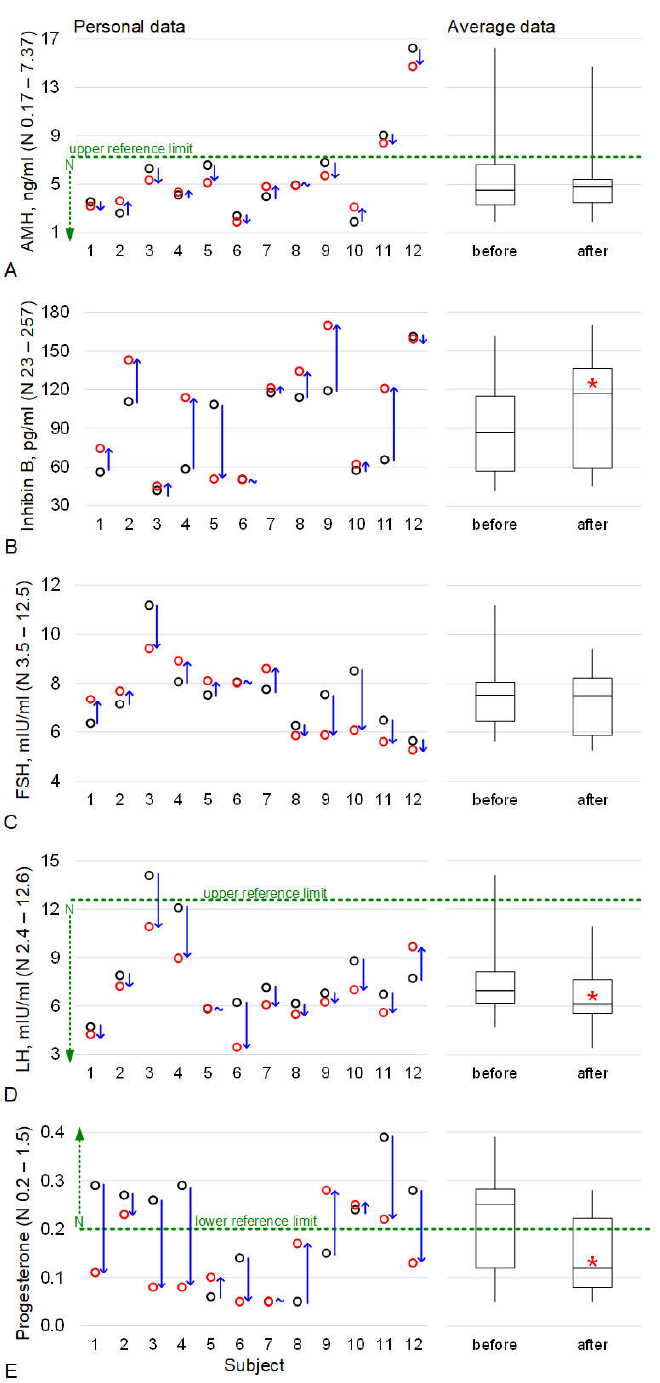
Figure 1. The concentration of hormones before and after a 5-day “dry” immersion. ( A ) anti-Mullerian hormone (AMH), ( B ) inhibin B, ( C ) follicle-stimulating hormone (FSH), ( D ) luteinizing hormone (LH), ( E ) progesterone (PG). The individual data are presented on the left side of each panel (1–12 are the conditional numbers of the subjects). The black circles indicate the values before immersion, the red circles indicate the values after immersion, and the direction of change is indicated in blue ( ↑ —increase, ↓ —decrease, ~—unchanged). Data are presented on the right side of each panel for the median ± range group. Before—value before immersion. After—value after immersion. * p < 0.05 in comparison to “before”. The green dotted lines indicate the upper or lower limit of the norm, if, for some subjects, the values were outside the reference range. The reference concentration is shown on a vertical scale for each hormone.